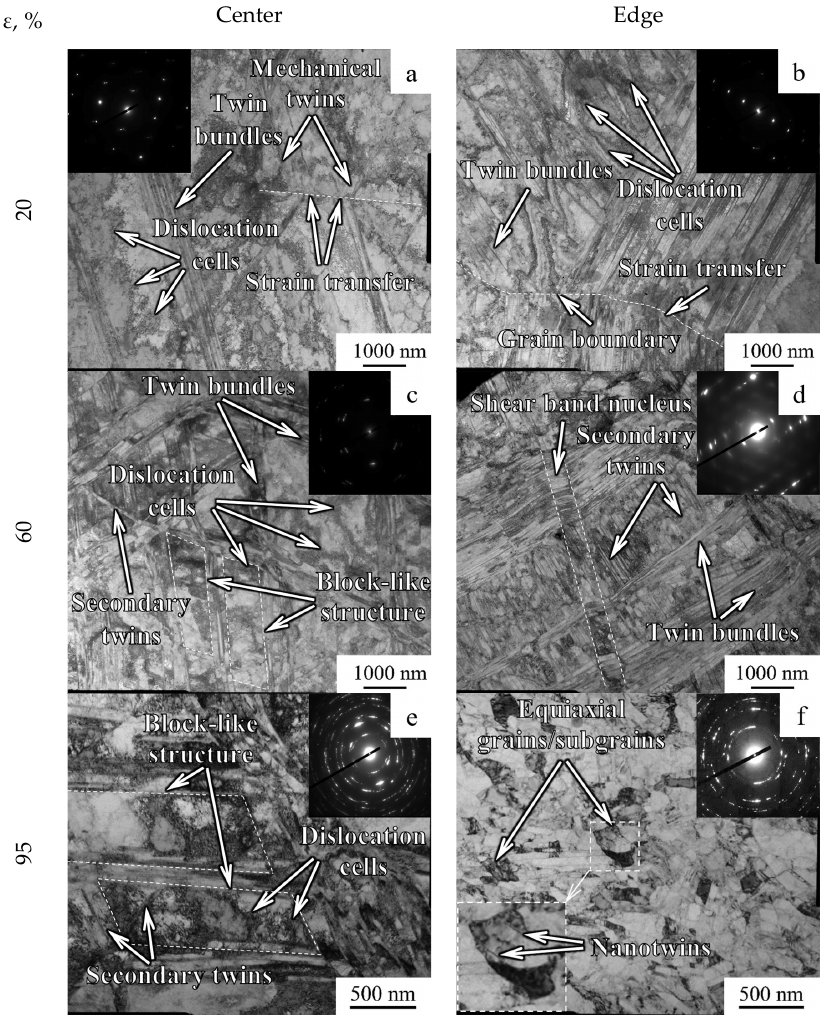
Figure 5. Transverse TEM structure in (a, c, e) the center and (b, d, f) edge after different swaging modes: (a, b) 20%, (c, d) 60%, (e, f) 95%.